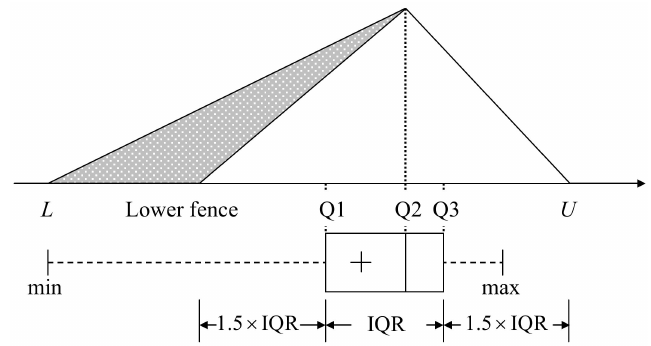
Figure 4. Using triangular MFs to form the shape of the attribute distribution.